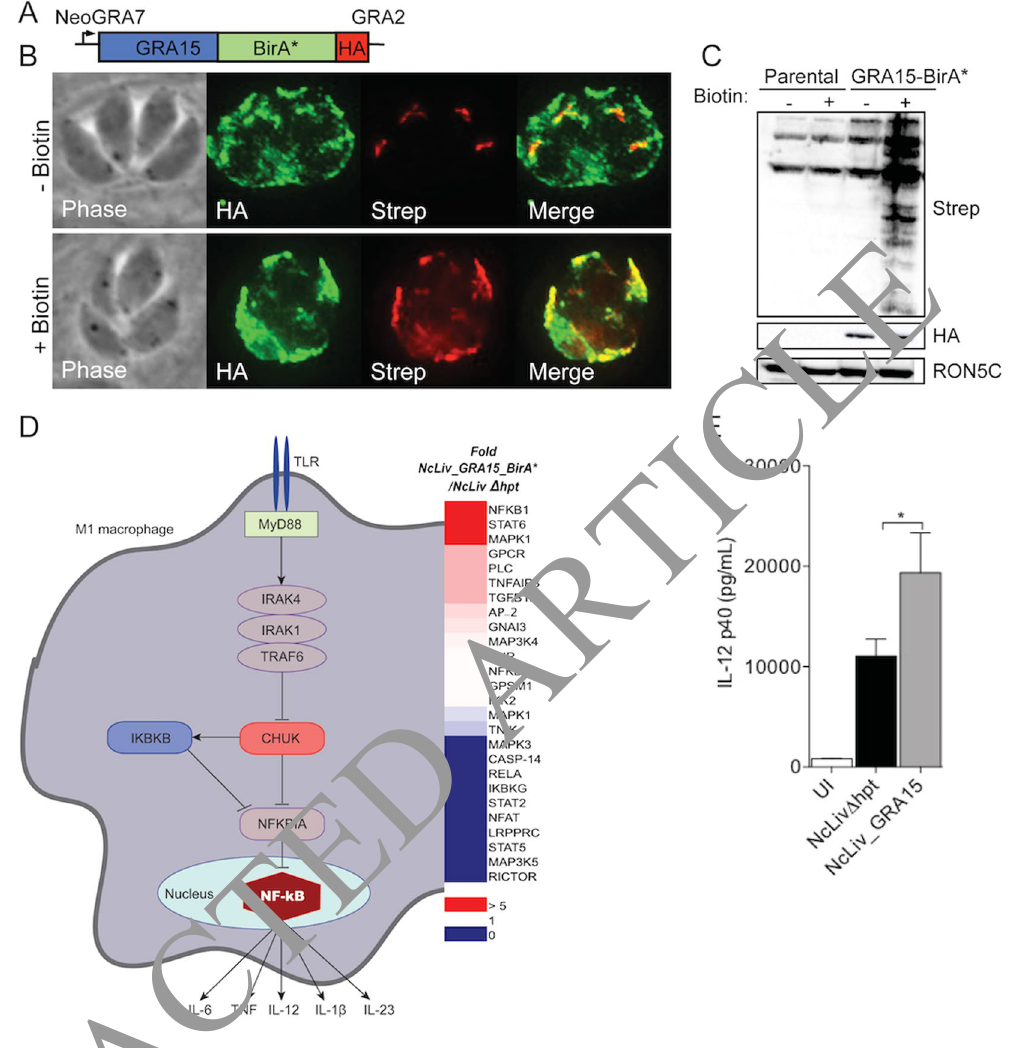
Figure 7. GRA15 expression in N. caninum upregulates the NF- κ B pathway members and increases IL-12p40 production. ( A ) Diagram of the expression cassette encoding GRA15 fused to BirA * , plus a C-terminal 3xHA epitope tag, driven by the GRA7 promoter, ( B ) IFA of GRA15-BirA * -expressing parasites, grown for 48 h with or without biotin. GRA15-BirA * localizes to the parasite dense granules and biotinylates proteins in a biotin- dependent manner. Endogenously biotinylated proteins in the apicoplast are detectable, even in the absence of biotin. Bottom panel, Green, mouse anti-HA antibody; red, streptavidin-Alexa 594. Microscope magnification: 63x, ( C ) Western blot comparing the profile of biotinylated proteins from lysates cells infected with parental and GRA15-BirA * parasites, ( D ) Diagram and heat map of the mass spectrometry results of the biotinylated proteins analyzed by the Pathway Studio software shows the upregulation of the NF- κ B pathway, ( E ) NcLiv_ GRA15 induces the upregulation of IL- 12p40 in macrophages. Values are representative of two independent experiments indicating mean ± SEM of cytokine levels in relation the standard curve ( * P < 0.05; ANOVA and Bonferroni multiple comparison post-test). Full-length blots are available in Supplementary dataset